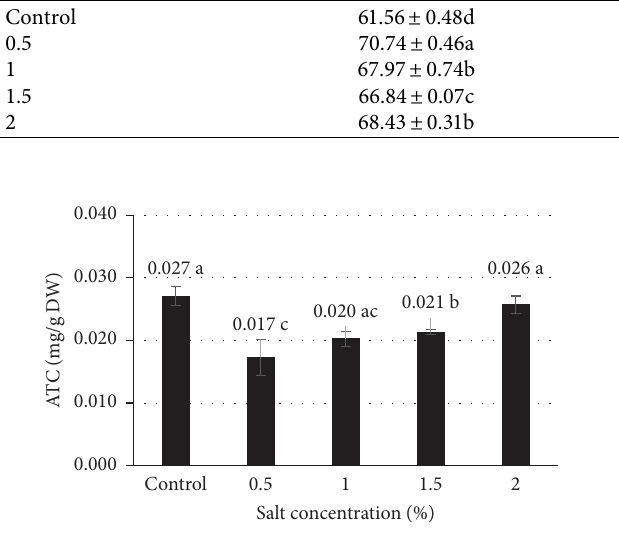
Figure 2: Efect of salt concentration during blanching on astaxanthin content.